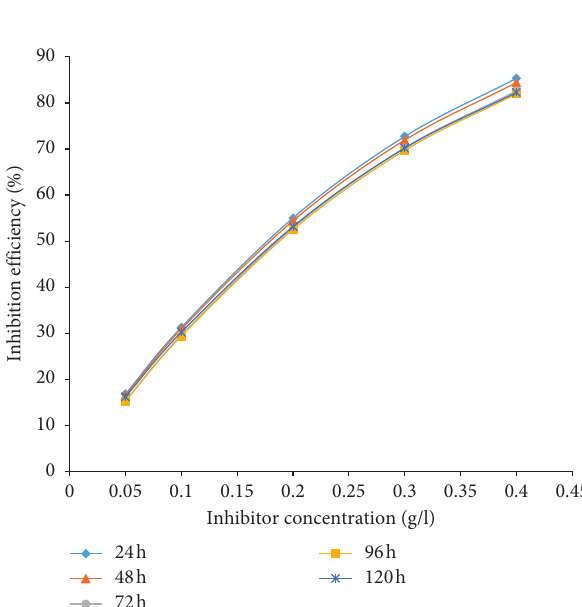
Figure 5: Plot of modelled inhibition efficiency (%) versus con- centration of MBZ for mild steel in dilute H 2 SO 4